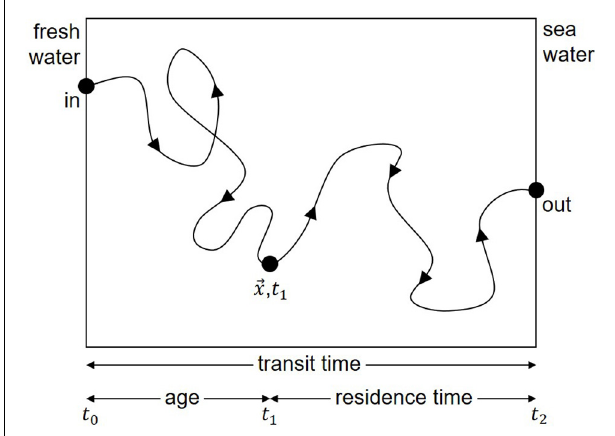
FIGURE 1 | Example illustrating the definitions of time scales according to Zimmerman (1976). The time difference t 1 –t 0 from entering the control volume to the actual position x is the “age” of a single water body. The time difference t 2 –t 1 from the actual position x to the edge of the control volume is the “residence time” of the water body. The sum of both is the “transit time” covering the time span from entering to leaving the control volume. If many water bodies are considered, the different time scales can be computed for each water body. Averaging over all water bodies results in “mean age”, “mean residence time” or “mean transit time”. Properties such as “turn-over time” (Bolin and Rohde, 1973) or “flushing time” (Zimmerman, 1976) cannot be displayed in this graph because they are defined by total volume divided by total flux. The “influence time” (Delhez et al., 2014) although defined differently, has a similarity to “age”. Consequently, the presence of eddies or loop currents would cause a longer pathway through the control volume and would result in longer time scales. A plot of the residence time as function of the starting point results in the LRT as function of space and time. The area averaged LRT is equivalent to the mean residence time.